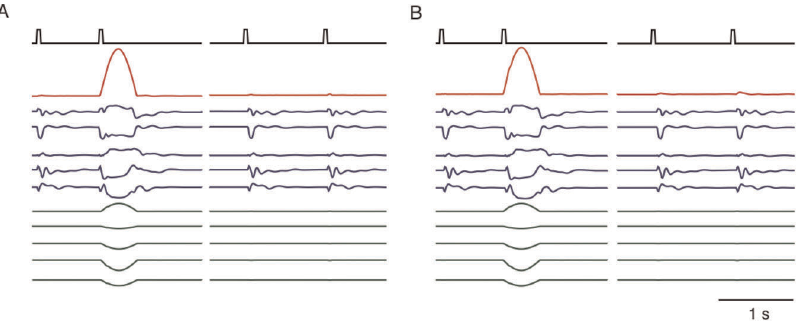
Figure 3. An example input-output task implemented in a network with feedback (A) and then transferred to a network without feedback using equation 21. The upper row shows the input to the network, consisting of two pulses separate by less than 1 s (left columns of A and B) or more than 1 s (right columns of A and B). The red traces show the output of the two networks correctly responding only to the input pulses separated by less than 1 s. The blue traces show 5 sample network units. The green traces show u i z ( t ) in A and d j T units. The similarity in these traces shows that the transfer was successful at getting the recurrent input in B to approximate well the feedback input in A for each